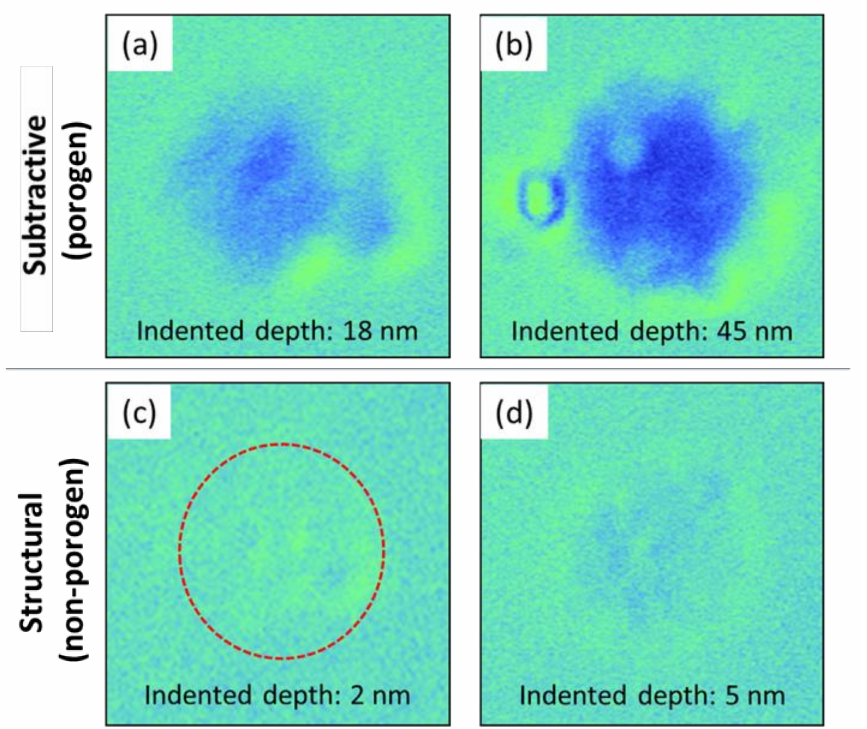
Figure 2. Comparison of viscoplastic deformation between subtractive and structural p-SiCOH films; ( a , c ) 1 h and ( b , d ) 4